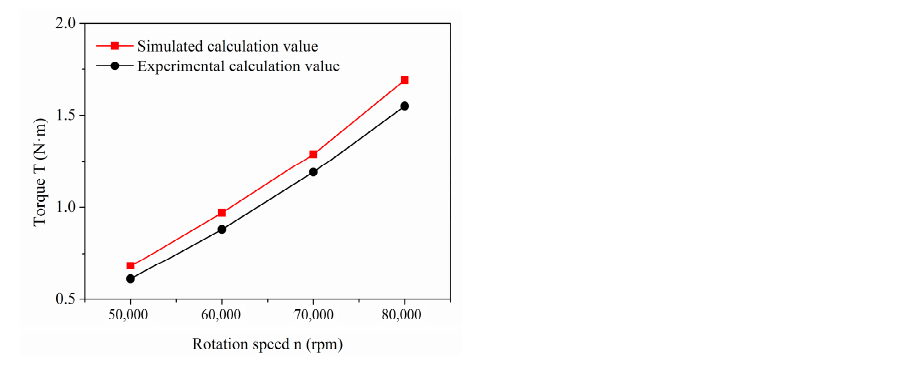
Figure 7. Comparison diagram of experimental test torque and simulation calculation torque.